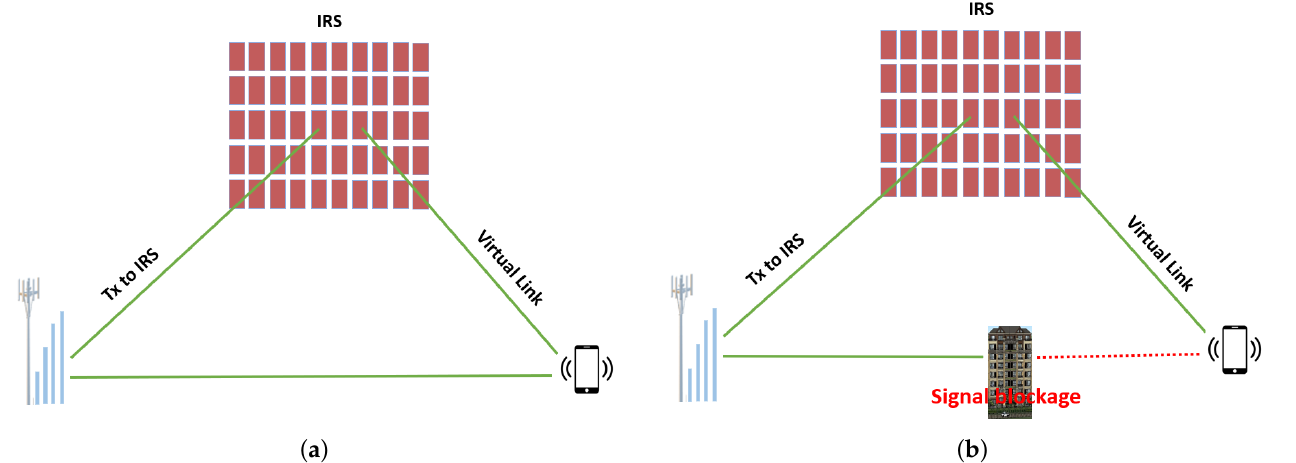
Figure 3. IRS-aided wireless transmission system: ( a ) In the presence of LoSlLink; ( b ) In the absence of LoS